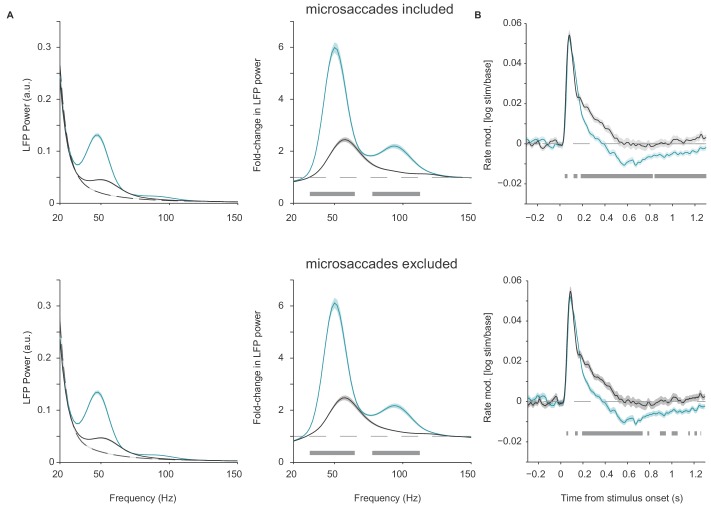
Control analysis for microsaccades.(A) Average LFP power spectra and rate modulation for chromatic (turquoise), achromatic (black) and baseline conditions, separately for data epochs defined irrespective of microsaccades (top) and epochs excluding 100 ms after each microsaccade. Microsaccade detection was based on the algorithm of Engbert and Kliegl (2003) (see Materials and methods). Analysis was based on same dataset as in Figure 1. Analyses were performed as for Figure 1, except that the Fourier spectra were computed based on 100 ms epochs that were Hann-tapered and zero-padded to 1 s. (B) Modulation of firing rate relative to baseline, expressed as log10 (stim/base), separately for data with microsaccade epochs included (top) and excluded (bottom).